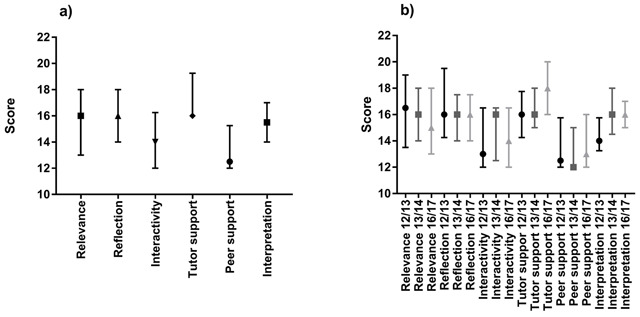
Shows the median and interquartile range scores for the six categories on the COLLES questionnaire: a) Combined scores of all three-year groups (2012/13, 2013/14 and 2016/17); b) Separate scores for each year group.